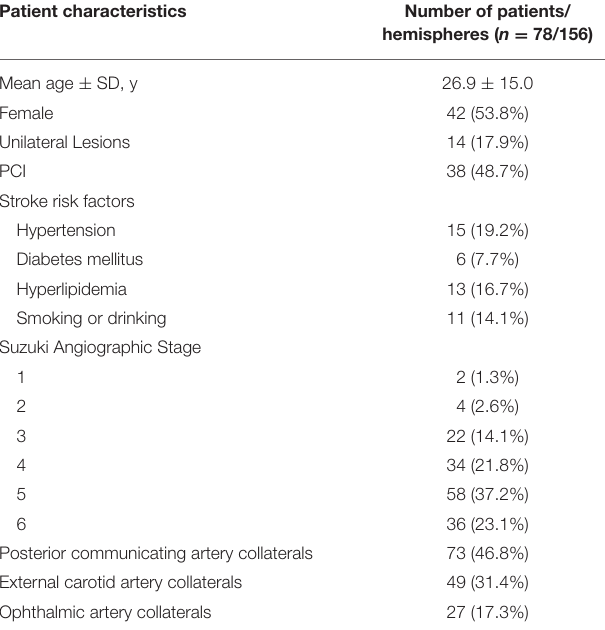
TABLE 2 | Comparison of neoangiogenesis at short-term and long-term